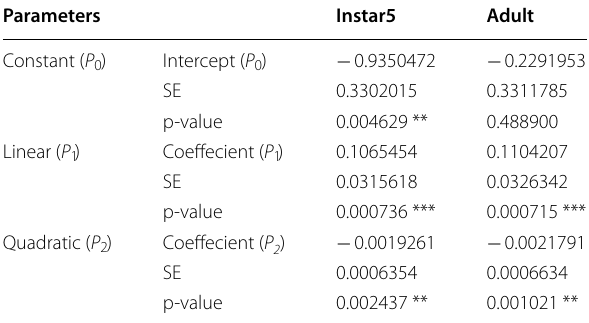
Table 3 Maximum likelihood estimates for parameters of the logistic model fit to proportion of F. schultzei larvae consumed by D. primarius versus initial prey density at 26 2 ±